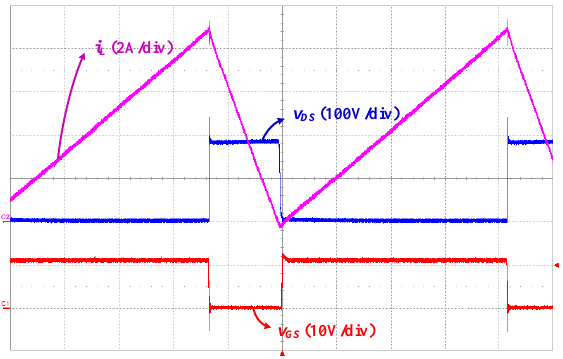
Figure 16. The turn-on ZVS waveform of the main switch S under full load conditions (20 ms/div).